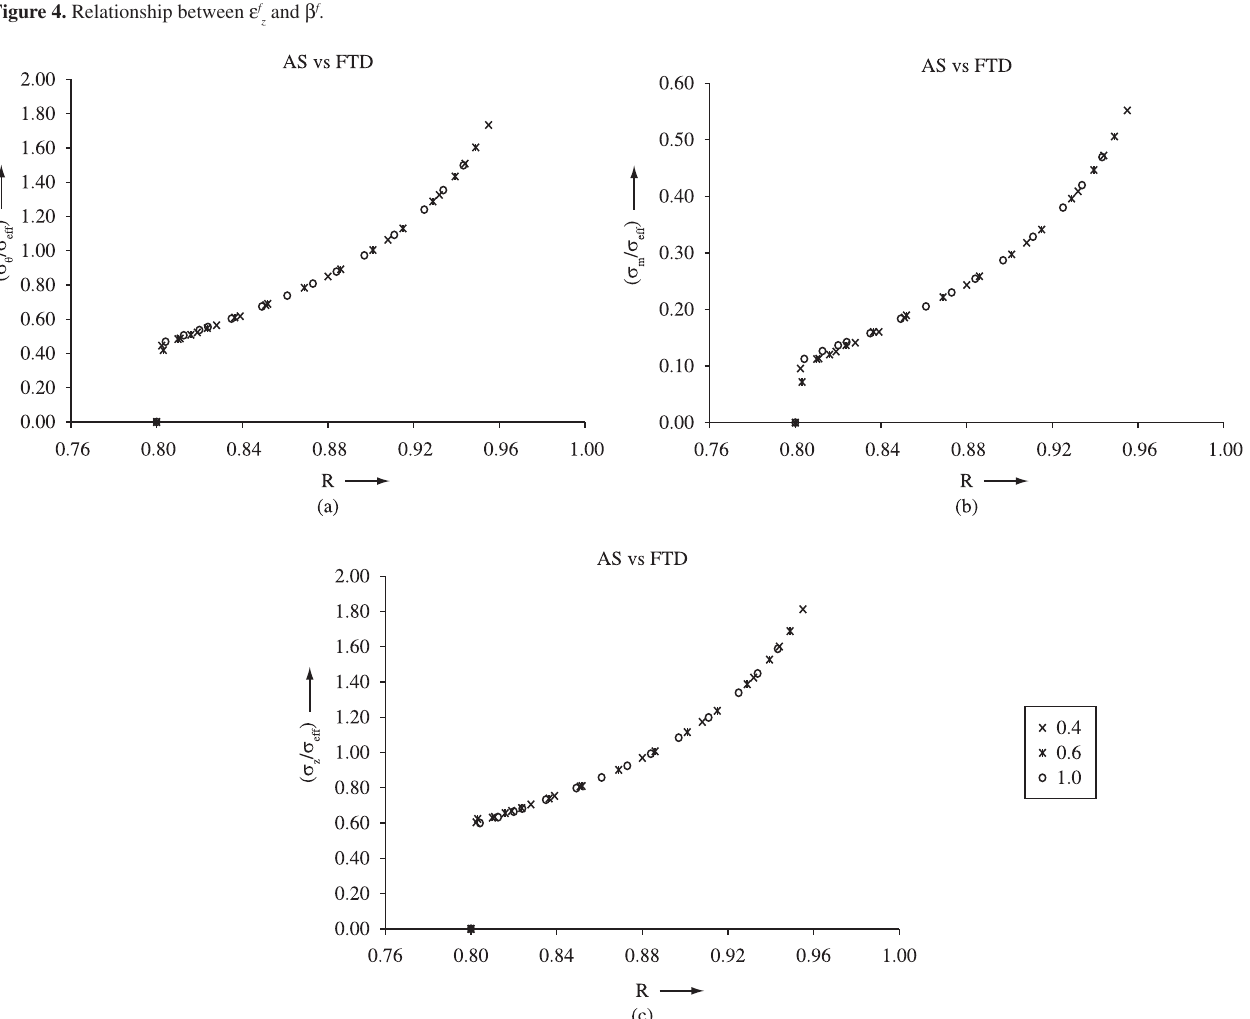
/ σ ) and R ; b) relationship between ( σ eff θ